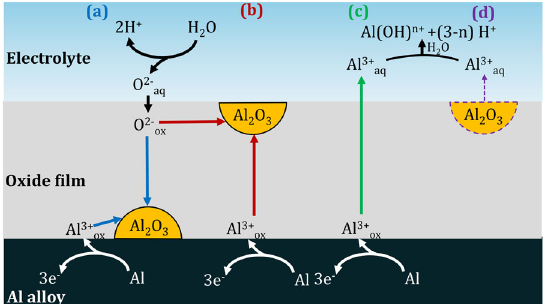
Fig. 5 Concurrent processes considered in the high fi eld model. a Oxide growth at the Al/Oxide interface from the migration of O 2 − . b Oxide growth at the Oxide/Electrolyte interface from the migration of Al 3 + . c Direct ejection and hydrolysis of Al 3 + . d Dissolution of Al 2 O 3